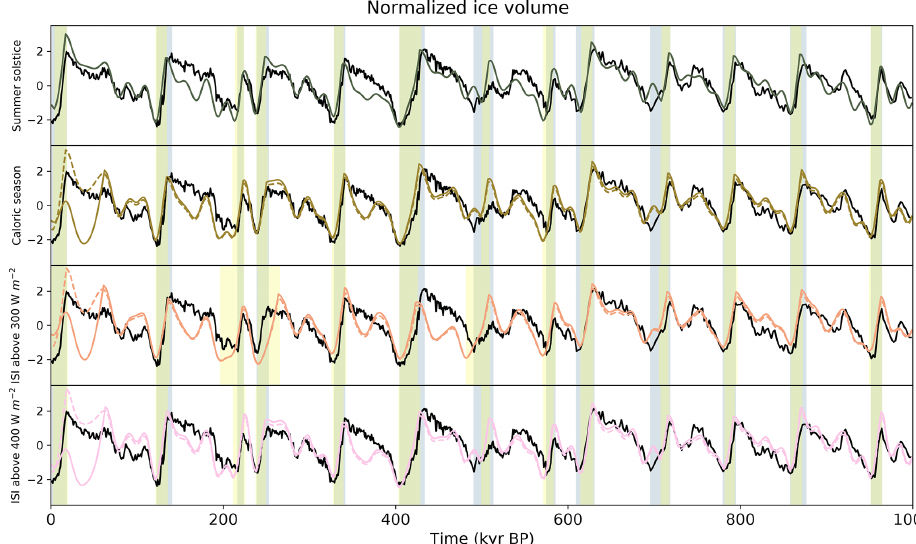
Figure 5. Normalized model results over the last 1 million years, with the different summer insolation forcings: insolation at the summer solstice, caloric season, ISI above 300Wm − 2 and ISI above 400Wm − 2 . The full coloured lines are the best fit computed over the 100– 1000ka period for each input insolation. The dashed lines represent the same solution, but with an increased V 0 threshold for the last deglaciation. The data (normalized LR04 stack curve) are in black. The blue shading represents deglaciation periods in the data. The yellow shading represents deglaciation periods in the model outputs (case of the increased V 0 threshold). This results in a green shading when deglaciations are seen in the model and data at the same